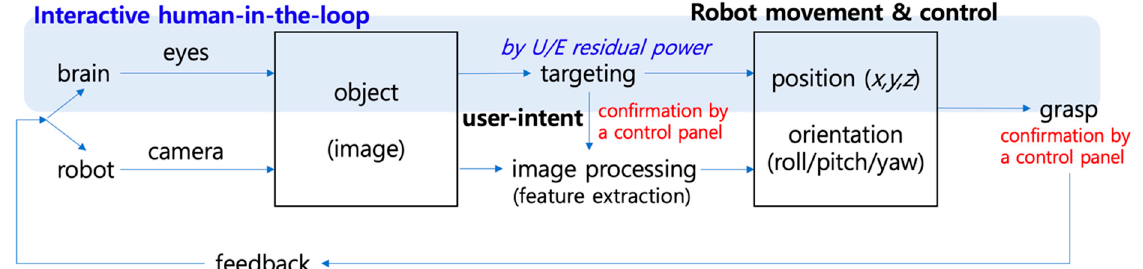
Figure 1. The basic concept of the interactive human-in-the-loop algorithm for the developed robot is shown. The components with a blue background indicate human contribution while other components indicate robot contribution. The red text indicates user confirmation by pressing a button on the control pad.